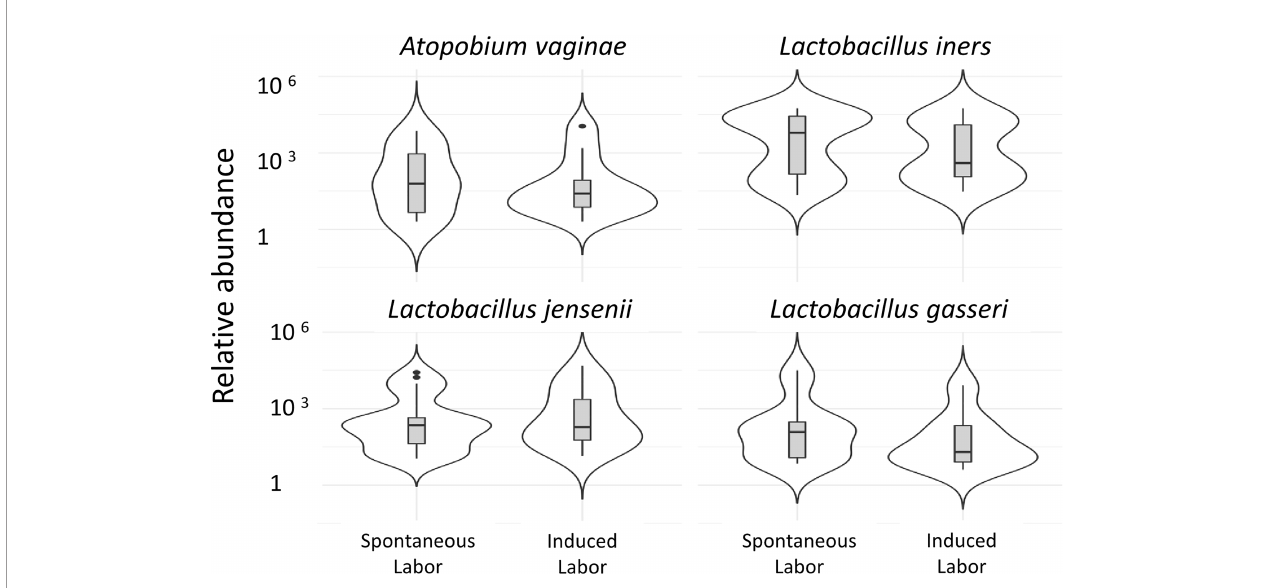
FIGURE 6 | Vaginal microbiota during pregnancy of spontaneously induced deliveries and arti fi cially induced deliveries. The correlation of the vaginal microbiome to induction of labor is demonstrated in the comparison of the vaginal microbiome of women in whom delivery was induced arti fi cially, group 1b (41 + 4 to 41 + 6) (n=12), to women whose delivery was induced spontaneously, group 1c (41 + 4 to 41 + 6) (n=8). Two of the pregnancy-related bacterial species, A. vaginae and L. jensenii , together with L. iners, L. gasseri were more abundant (Log 2 -fold change>-20 except for L. iners Log 2 -fold change=-7, adjusted p<0.04, Table S1 ) in women who proceeded to spontaneous delivery vs. those, whose labor needed arti fi cial